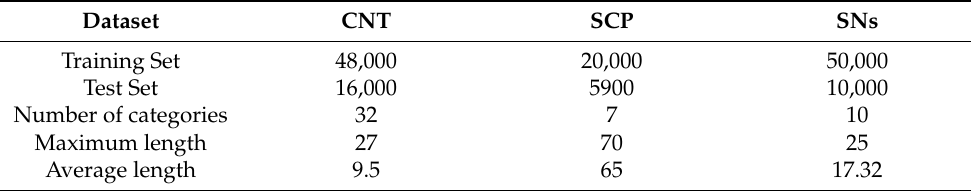
Table 2. Details of Chinese short-text public data